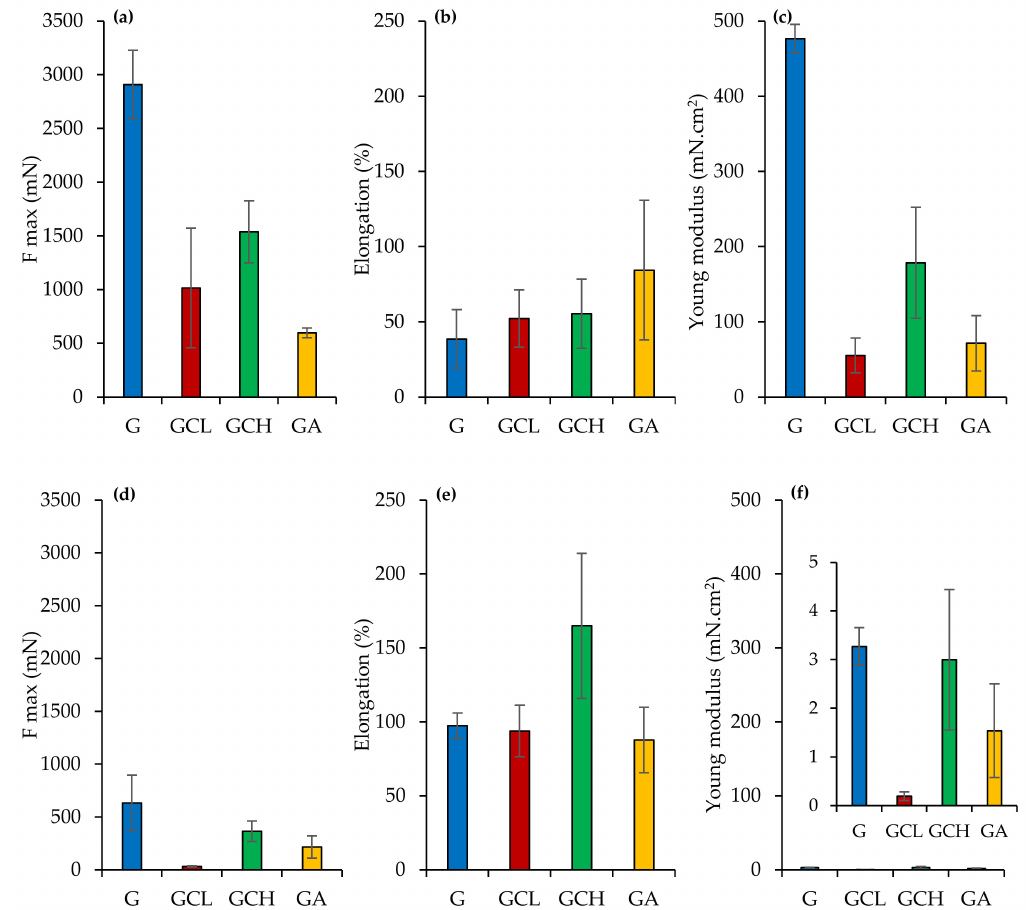
Figure 6. Mechanical properties (force at break mN, a – d ; elongation %, b – e ; Young’s modulus mN · cm 2 , c – f ) for dry ( a – c ) and wet ( d – f ) scaffolds (mean values ± sd; n = 3). ANOVA one-way; Scheff é ’s test ( p < 0.05): ( a ) G vs. GCL, GCH, GA; GGH vs. GA; ( c ) = G vs. GCL, GCH, GA; GCL vs. GCH; GCH vs. GA; ( d ) = G vs. GCL, GA; GCL vs. GCH; ( a ) vs. ( d ) = G, GCL, GCH; ( b ) vs. ( e ) = GCH; ( c ) vs. ( f ) G, GCL, GCH,